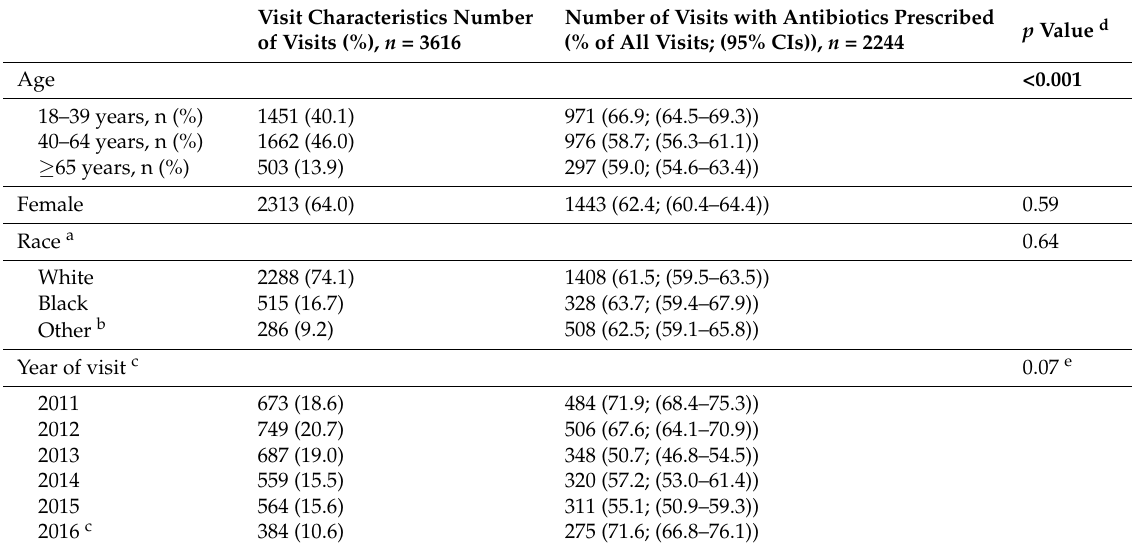
Table 1. Characteristics of all visits for acute uncomplicated bronchitis with and without antibiotic prescriptions,